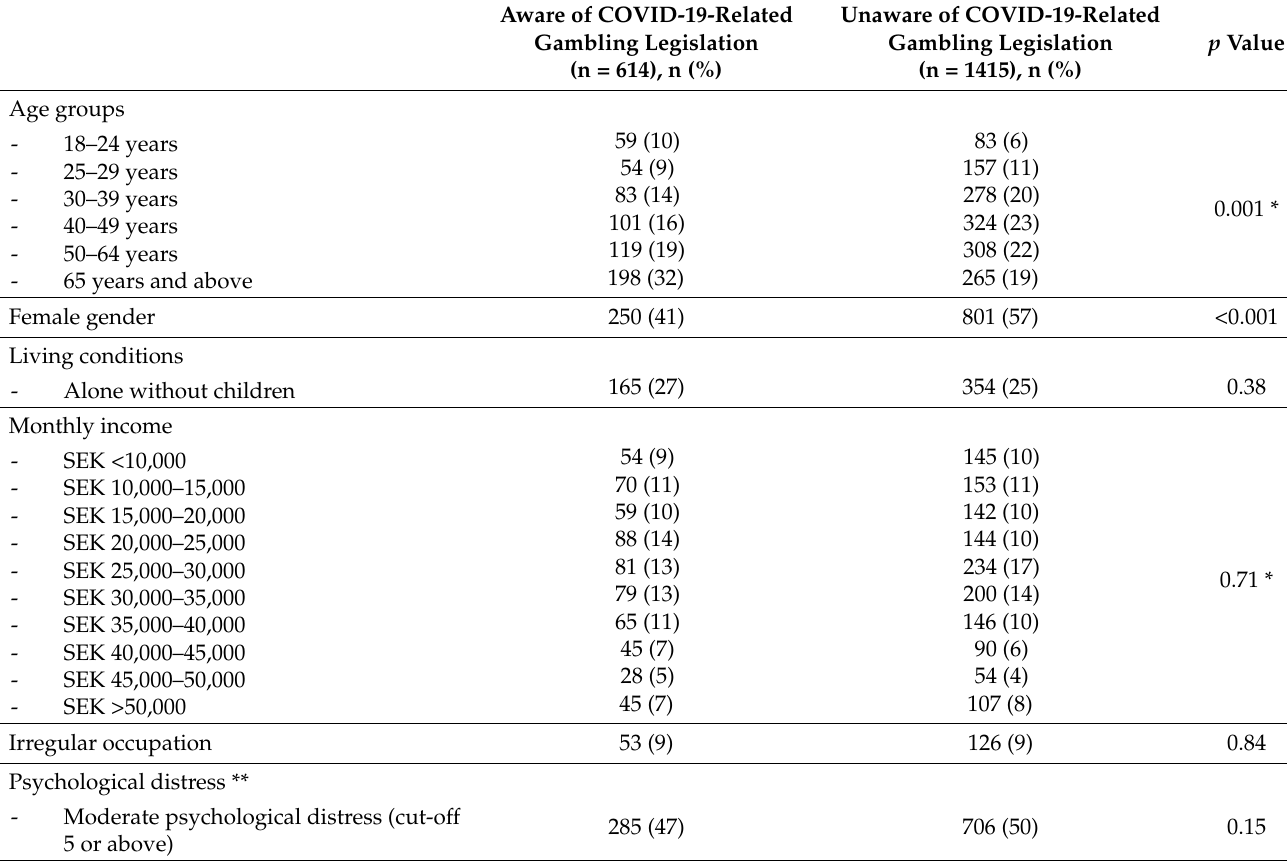
Table 6. Variables associated with awareness of COVID-19 legislation for gambling. Aware of